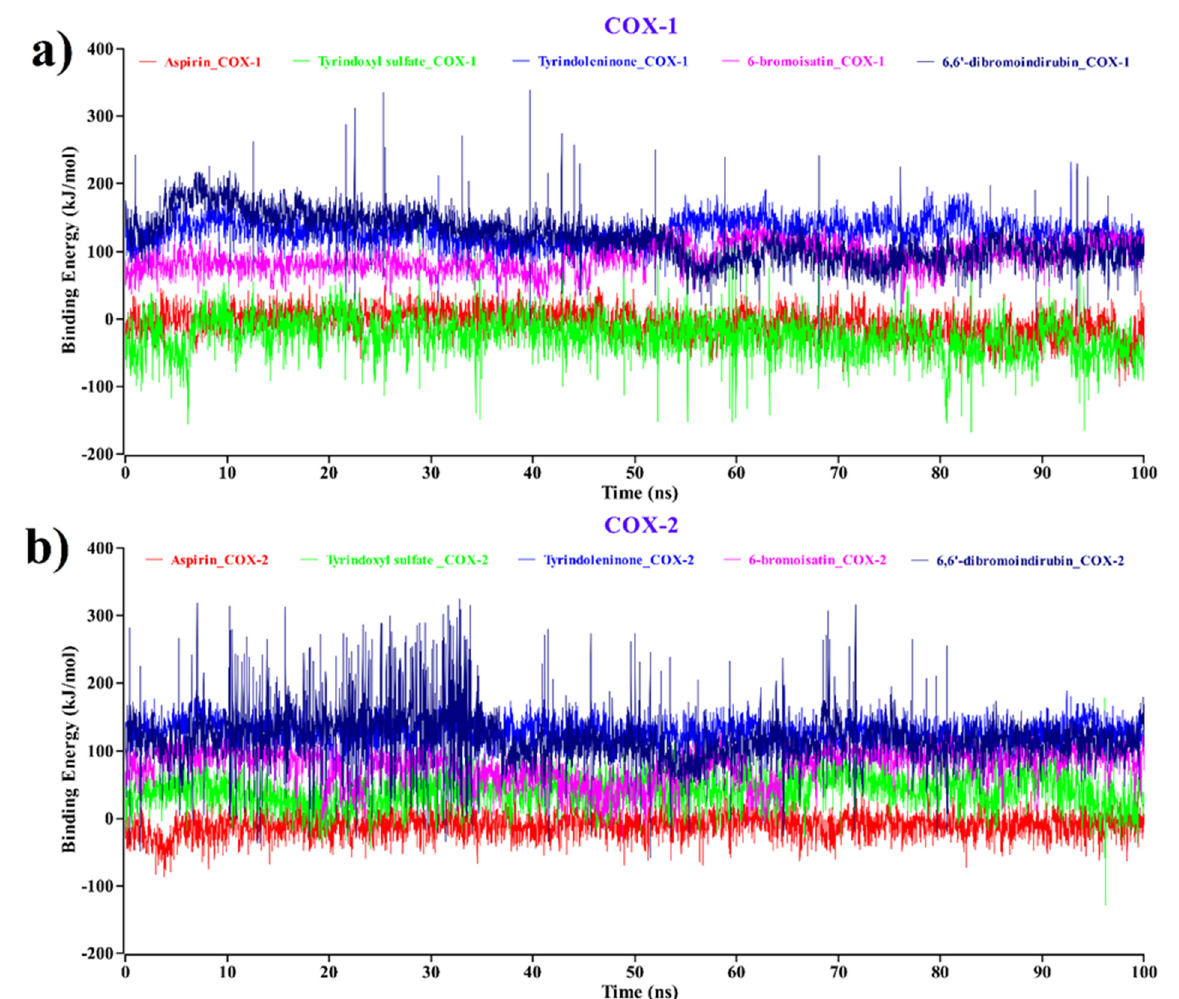
Figure 8. Binding free energy (in kJ mol − 1 ) of each snapshot was calculated by molecular mechanics–Poisson–Boltzmann surface area (MM–PBSA) analysis, representing the change in binding stability of each docked complex for ( a ) COX-1 and ( b ) COX-2. Complexes: red—aspirin, green—tyrindoxyl sulfate, blue—tyrindoleninone, magenta—6-bromoisatin, navy blue—6,6 (cid:48)